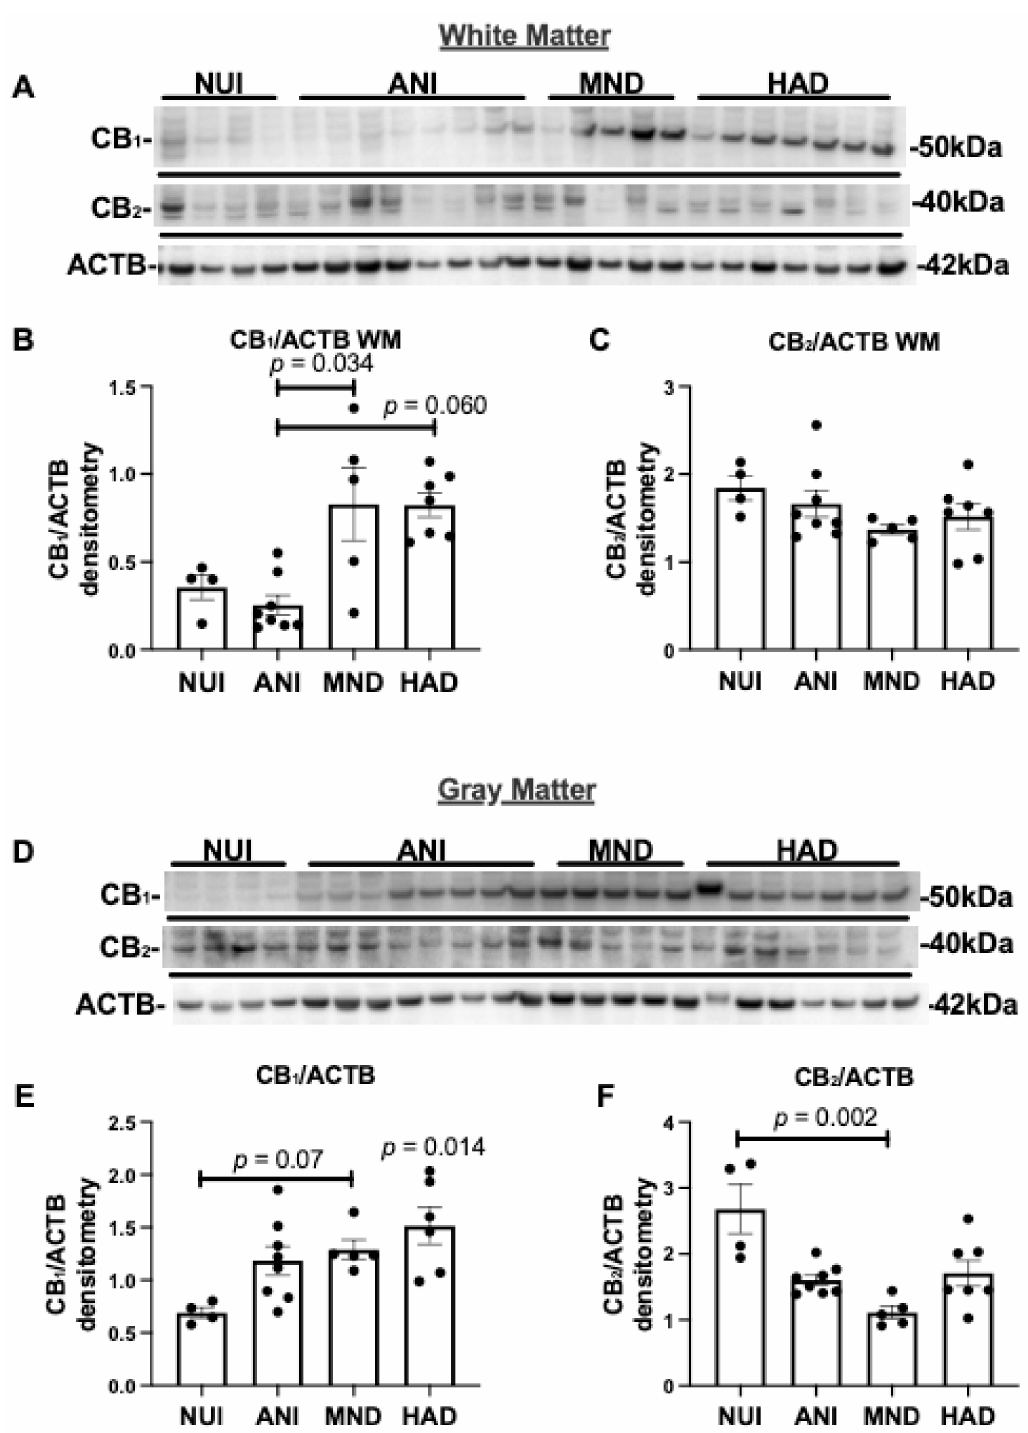
Figure 1. Cannabinoid (CB) 1 and CB 2 expression are increased in HIV associated neurocognitive disorder (HAND) brains on antiretroviral therapy (ART): ( A ) Immunoblot of HAND donor white matter (WM) frontal lobe (Brodmann area 46) lysates with antibodies specific for CB 1 and CB 2 , and β -actin ACTB. ( B , C ) Quantification of normalized band intensity of CB 1 and CB 2 in WM stratified by HAND diagnosis. ( D ) Immunoblot of HAND donor gray matter (GM) frontal lobe lysates with antibodies specific for CB 1 and CB 2 , and ACTB. ( E , F ) Quantification of normalized band intensity of CB 1 and CB 2 in GM stratified by HAND diagnosis. Samples were run on immunoblot in the same order as listed in Table 1. Statistical significance was determined by Kruskal–Wallis test; Error bars represent standard error of the